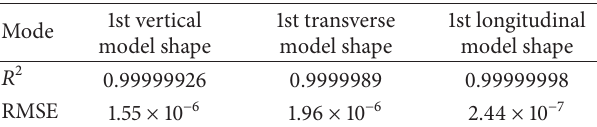
Table 7: 𝑅 2 and RMSE values.